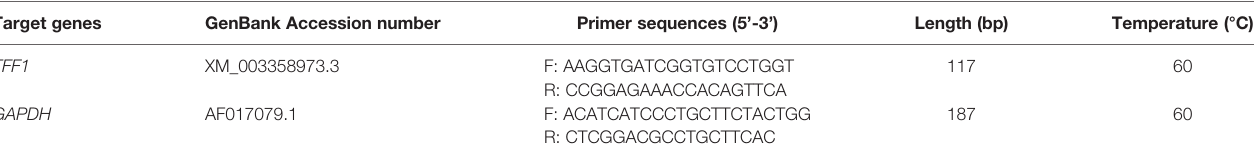
TABLE 4 | RT-qPCR primers and sequence information.